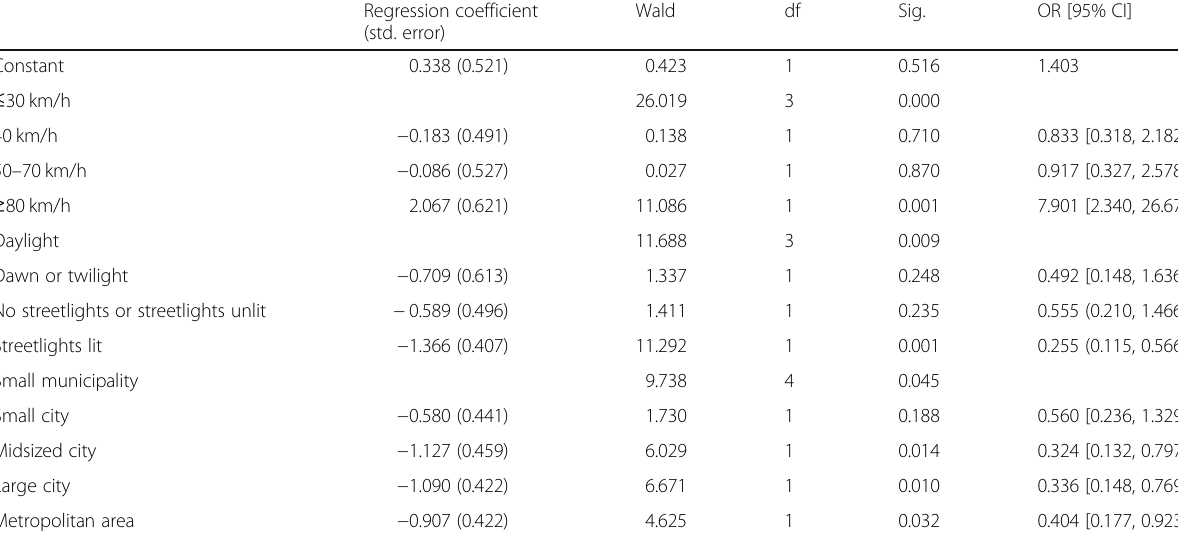
Table 4 Significant variables and related estimates and odds ratios for binary logistic model